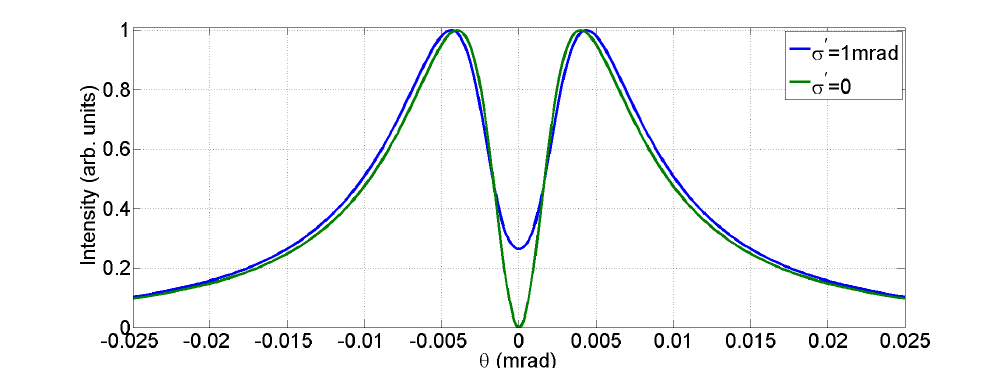
Figure 7. OTR angular distribution line profile with (blue) and without (green) angular divergence for a 125 MeV electron beam and σ (cid:48) = 1 mrad. The effect of a finite beam divergence is the increasing of the central minimum [24].